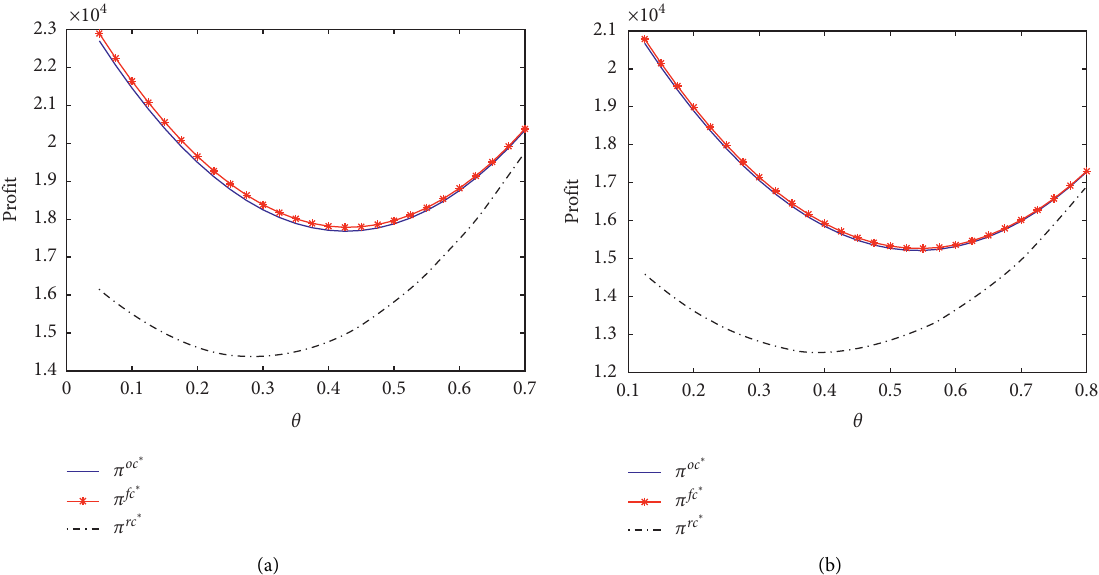
Figure 5: Effect of r on the DCR’s system profit. (a) r � 0 . 1 ( w � 0 . 2 and v � 0 . 2); (b) r � 0 . 3 ( w � 0 . 2 and v � 0 .